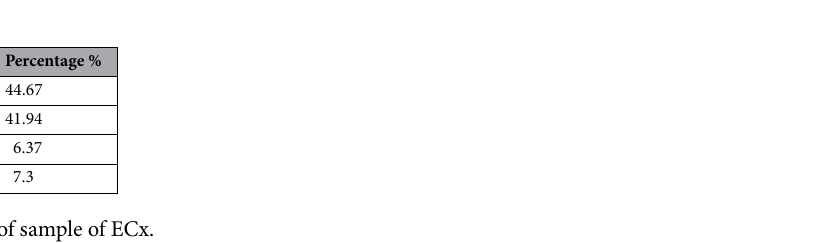
Table 2. Features of sample of